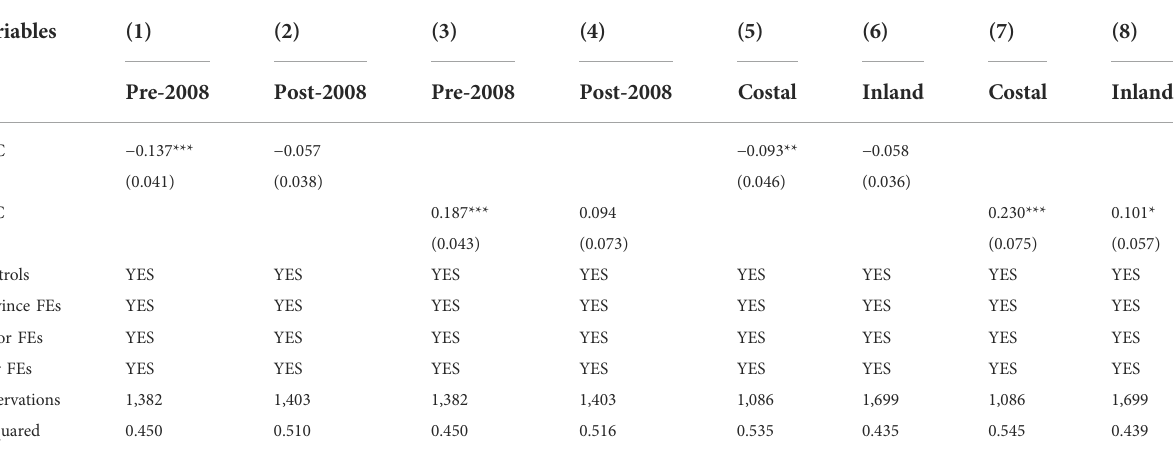
TABLE 7 Heterogeneity regression results